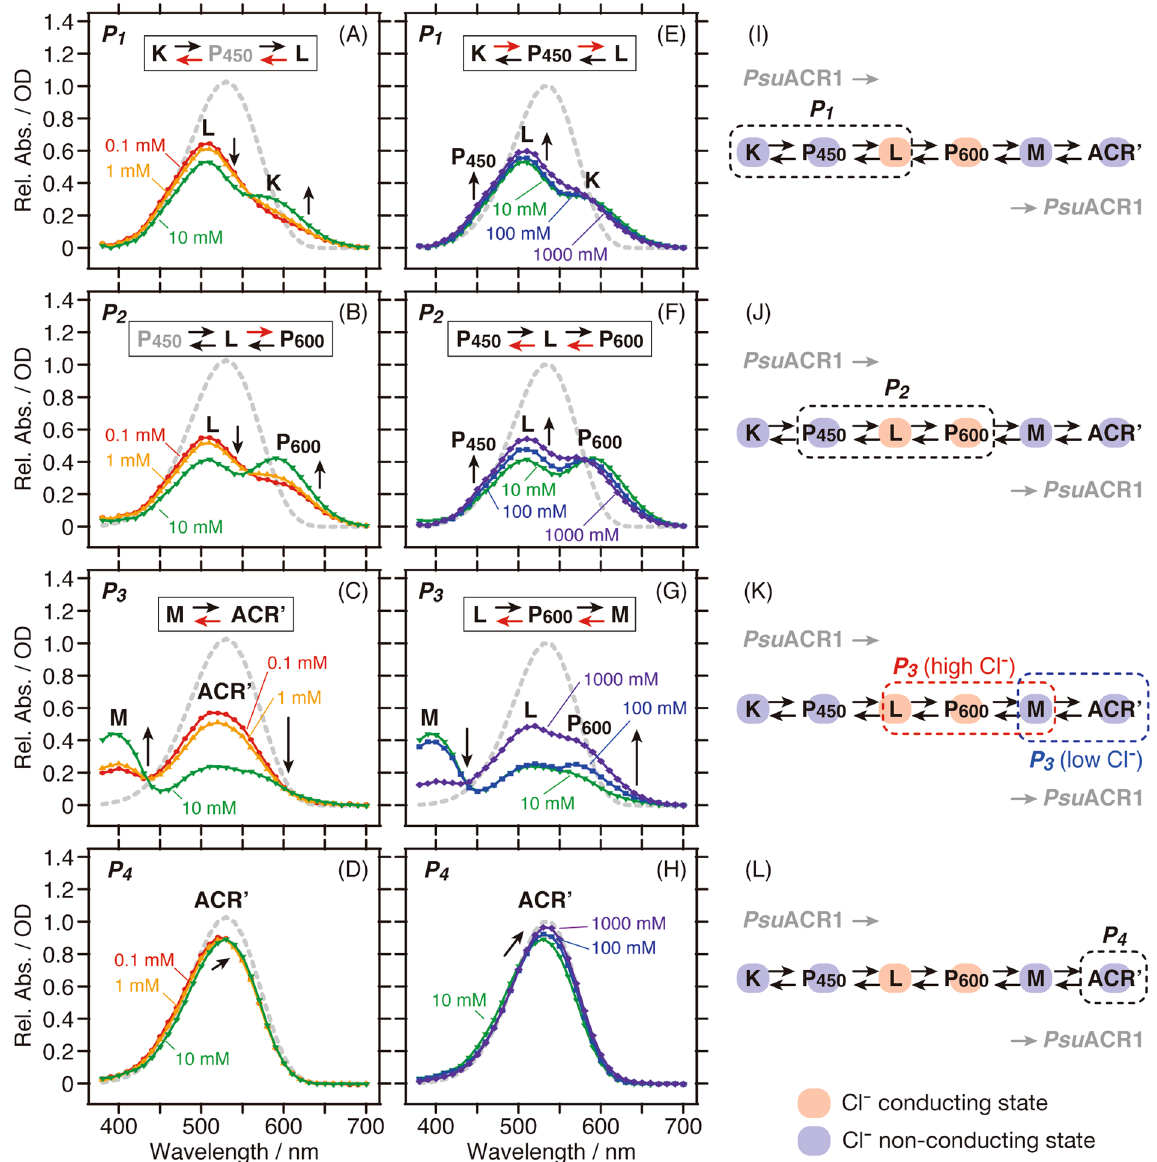
Figure 4. The Cl − dependence on the absorption spectra of the P 1 – P 4 states (from the top to the bottom) in the presence of ( A – D ) 0.1–10 mM (red, orange and green, respectively) and ( E – H ) 10–1,000 mM Cl − (green, blue and purple, respectively). The spectrum of P 0 (grey broken line) represents pure retinal spectra. The arrows indicate the direction of the changes in absorption and accumulation. For better understanding, the assignment and the equilibrium state of the photo-intermediates are shown in each panel. The Cl − dependent equilibrium shift is indicated by the red arrow. ( I – L ) The photo-intermediates in the P 1 – P 4 states are illustrated in the photocycle scheme of Psu ACR1. The Cl − conducting and non-conducting states are highlighted in red and blue,